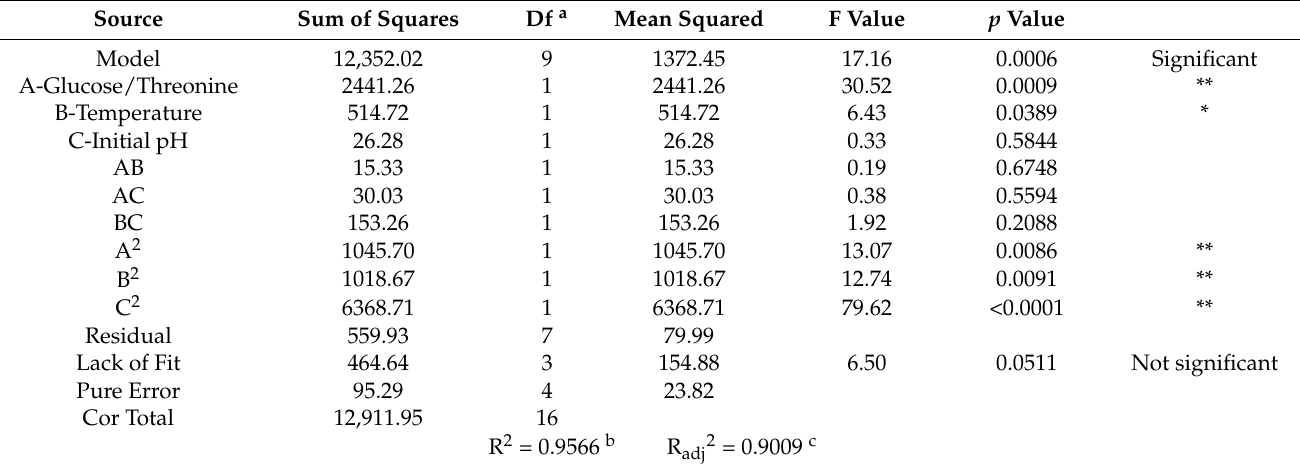
Table 3. ANOVA for the response surface quadratic